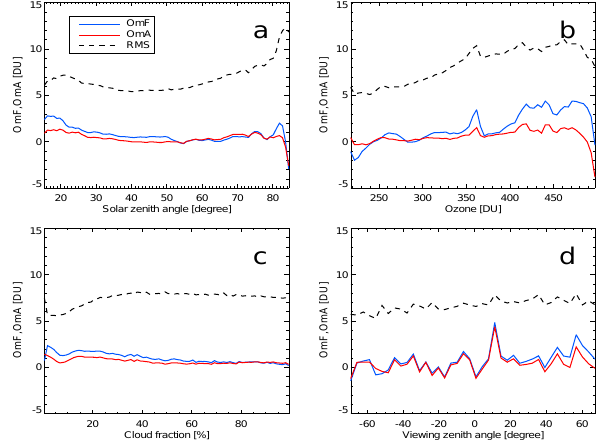
Fig. 9. The observation-minus-forecast in DU (blue line) and the observation-minus-analysis (red line) as a function of solar zenith angle (a) , observed ozone (b) , cloud fraction (c) , and viewing zenith angle (d) . The dashed line represents the RMS value of the observation-minus-forecast distribution. All data are averaged over January